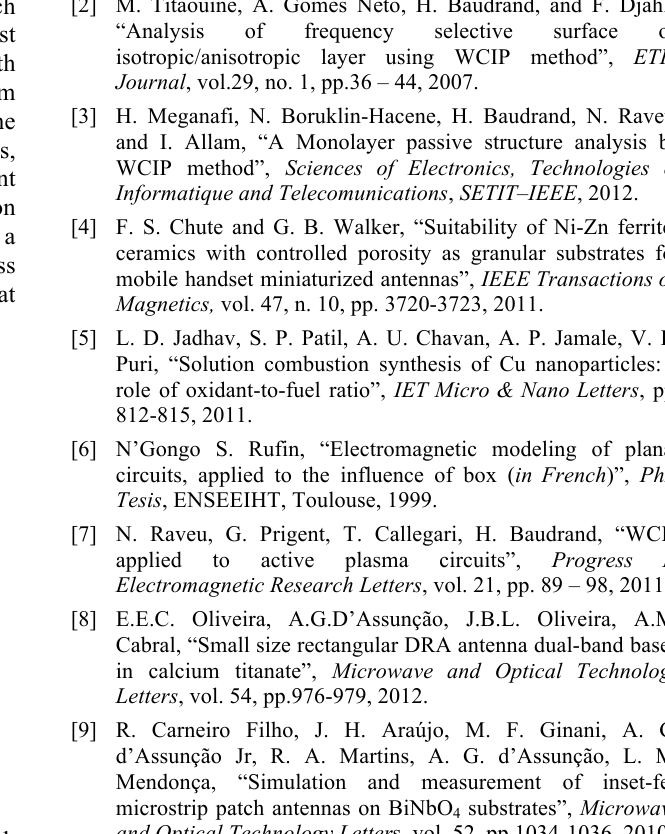
Figure 9: Return loss versus frequency for circular patch antenna on nanostructured suspended